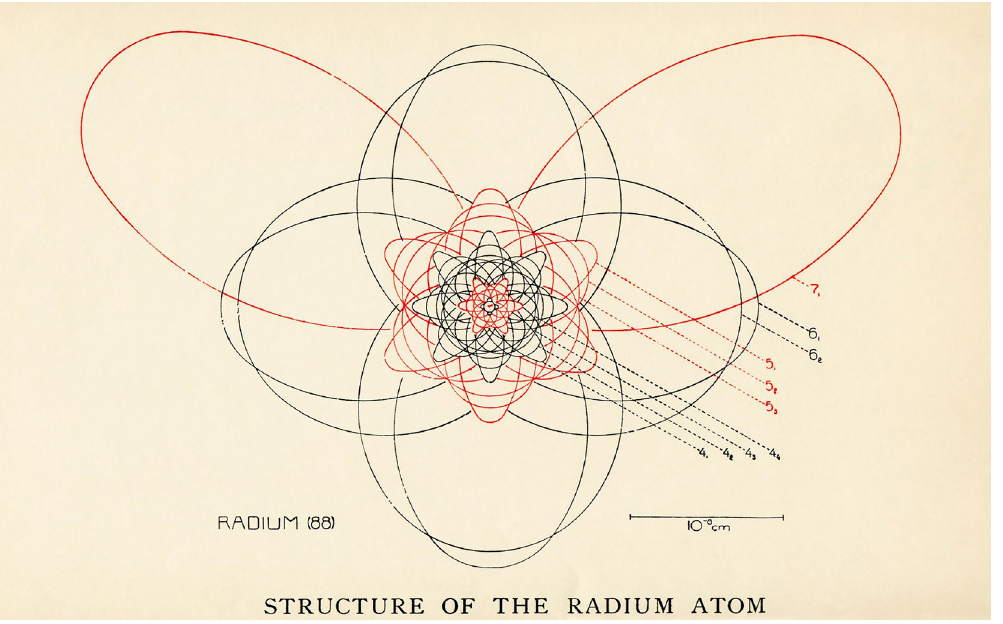
Fig. 3 The first image ever of the Structure of the Radium